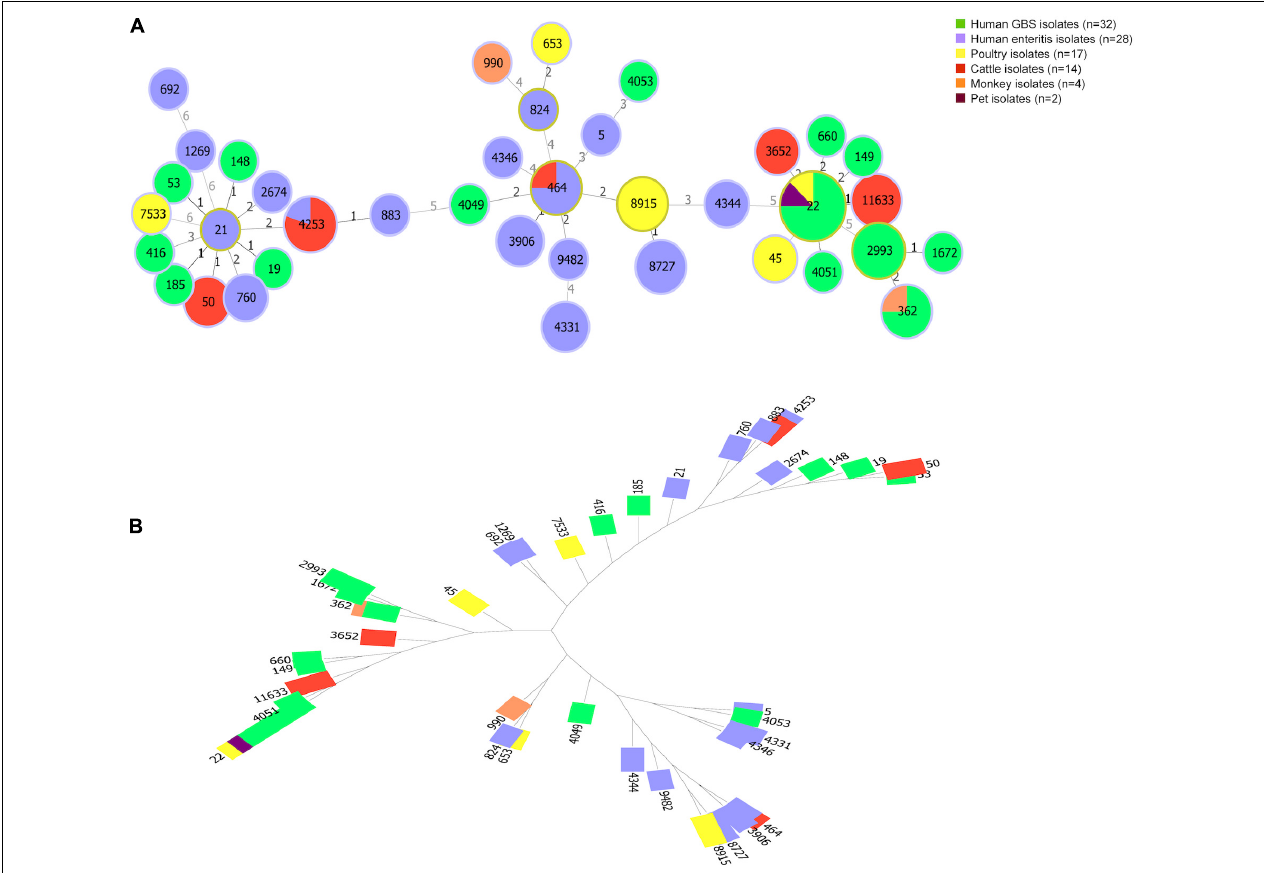
FIGURE 3 | Genetic diversity of Campylobacter jejuni isolates from animals and patients. (A) The minimum spanning tree shows population structure of C. jejuni isolates. Circles correspond to different sequence types. The size of circle proportional to the number of isolates with a certain sequence type. Colors of the circles indicate isolates from different sources. (B) A tree constructed by Neighbor Joinning algorithm. Saitou–Nei criterion was selected for tree branch-length